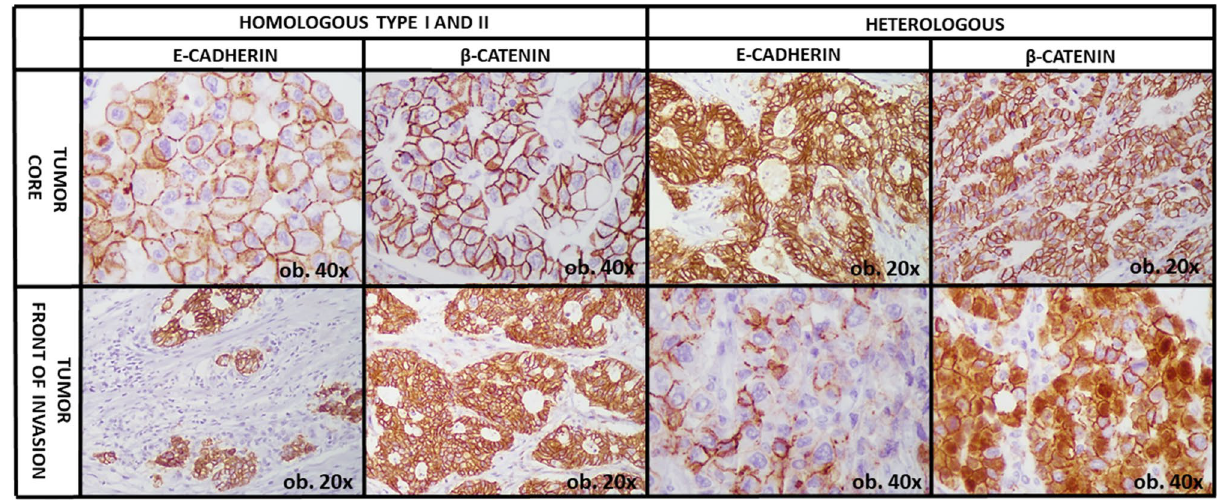
Figure 4. Homologous type I and II patterns of VSIG1 expression exhibit an epithelial phenotype, with synchronous membrane expression for E-cadherin and β-catenin. In contrast, VSIG1-heterologous cases are rather mesenchymal-type, with total or partial loss of E-cadherin and membrane-nuclear translocation of β-catenin.